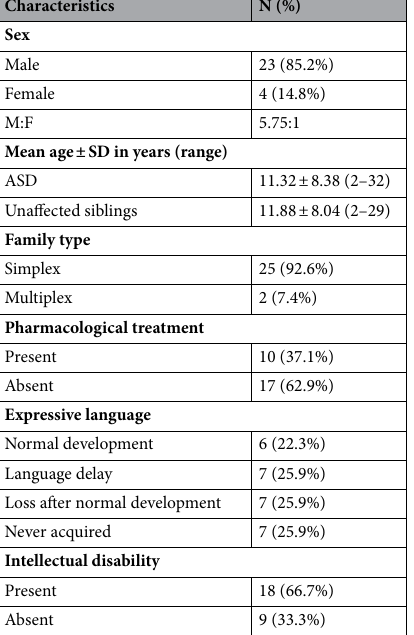
Table 1. Demographic and clinical characteristics of the 27 pairs of autistic and unaffected siblings recruited in this study.